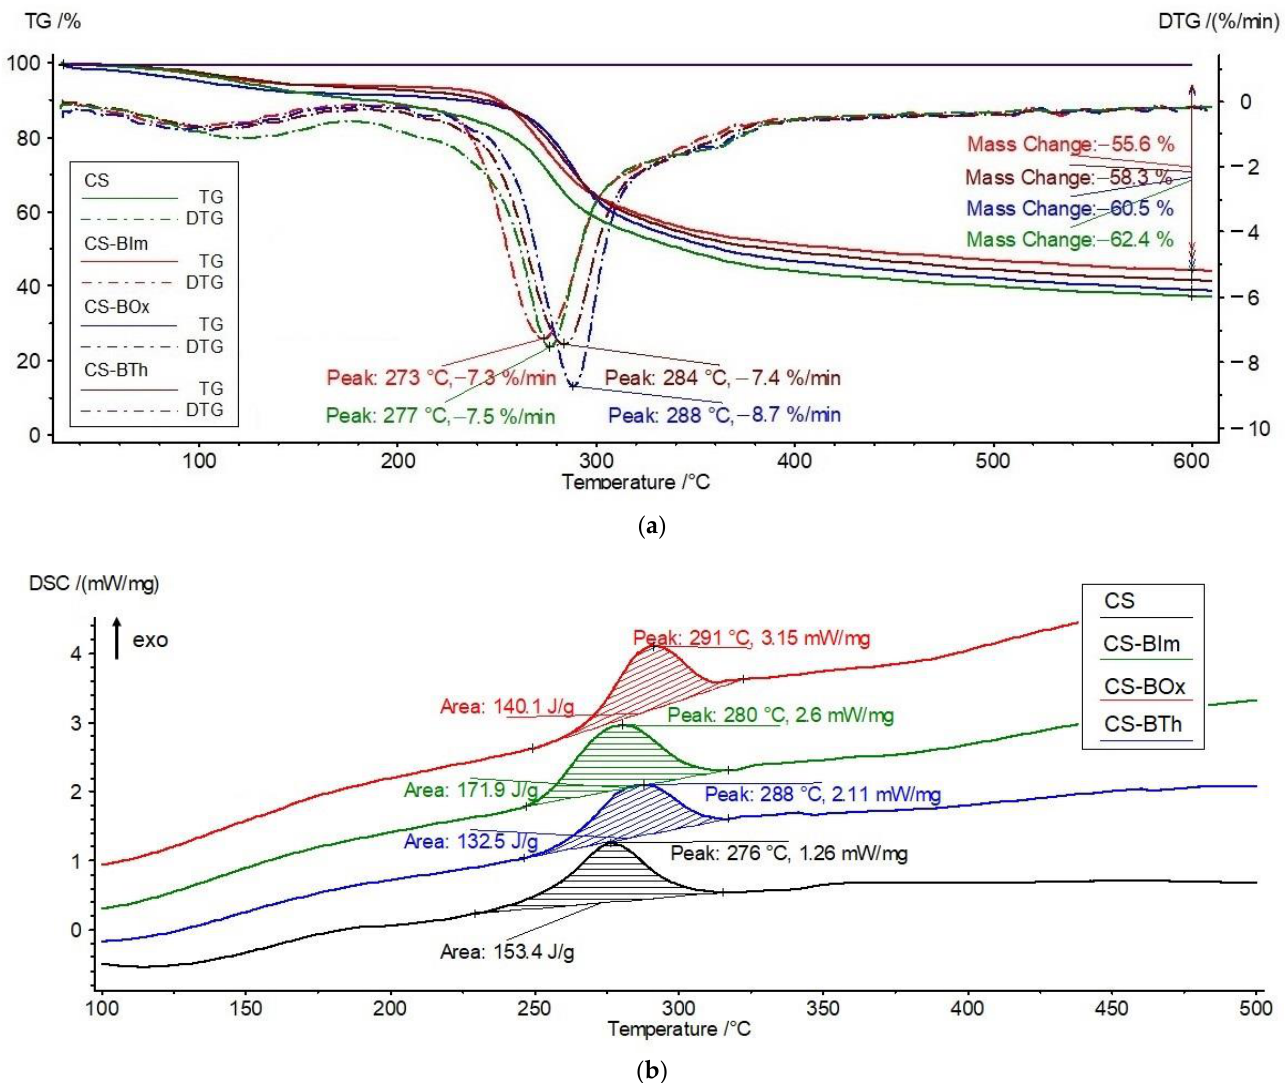
Table 2. Thermal parameters of unirradiated (0 h) chitosan and modified chitosan samples deter- mined from TGA/DSC analysis.